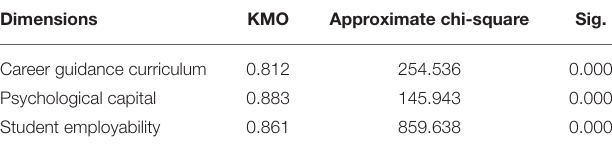
TABLE 3 | Validity analysis results of the QS.